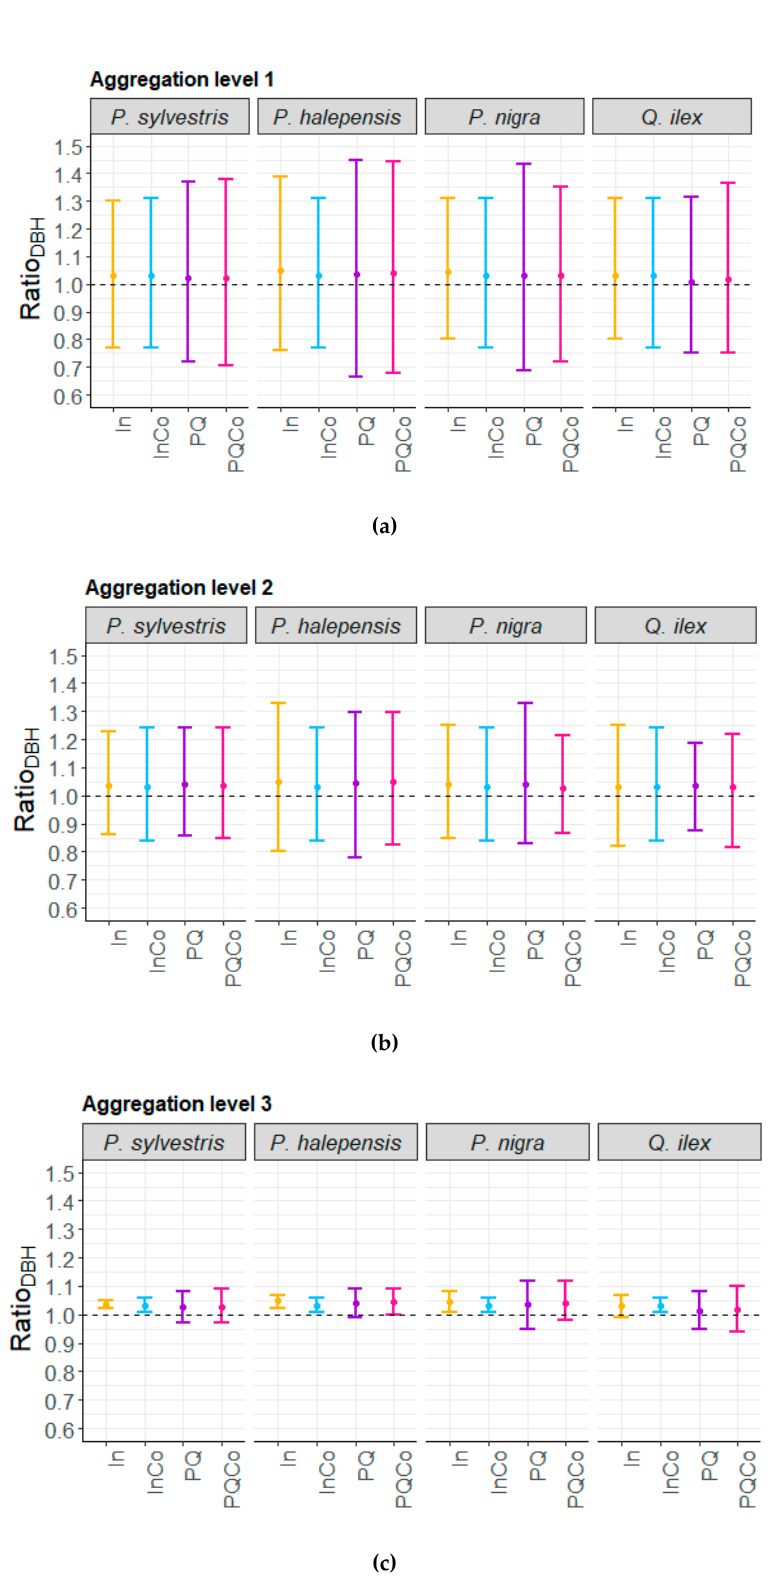
Figure 4. Ratio of predicted over observed DBH for 95% of the data for three resolution levels: individual (In) and plot-quantile (PQ) (i.e., level 1, ( a )), plot (level 2, ( b )), and the whole area of the studio (level 3, ( c )), considering two aggregation levels (individual and plot-quantile classes), two Equations (1) and (2) (Co for competition), and four species ( Pinus sylvestris , Pinus halepensis , Pinus nigra , and Quercus ilex